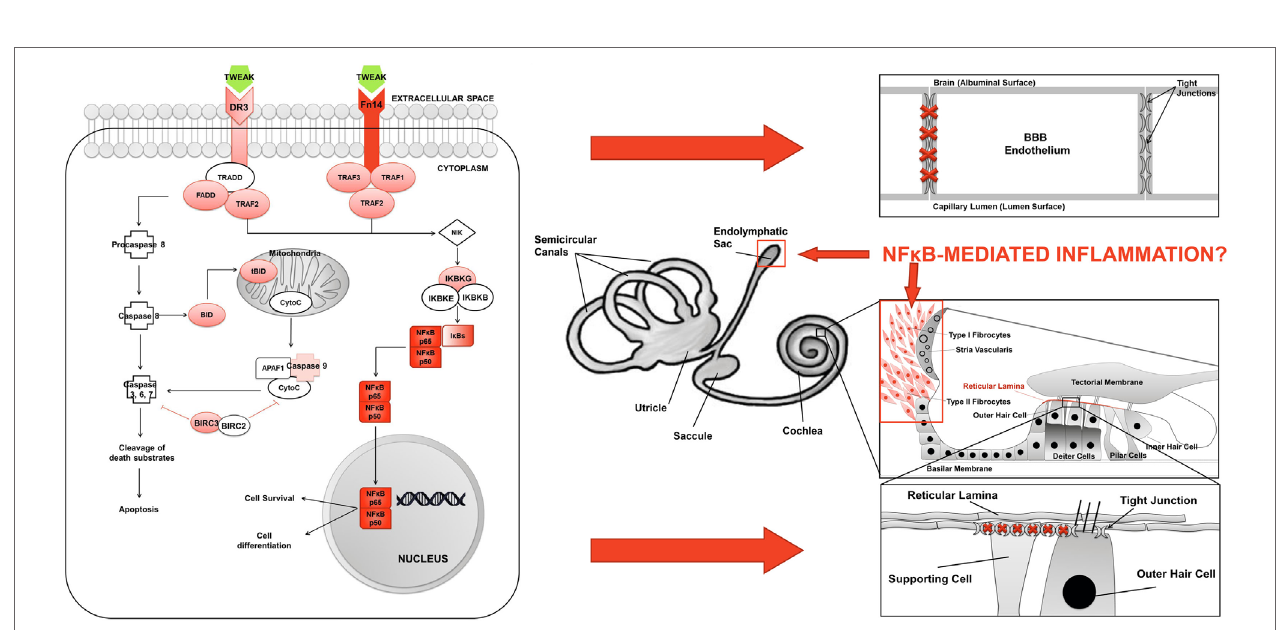
FigUre 5 | Fn14 and NF- κ B expression in homozygous lymphoblastoid cell lines (LCLs). Confocal microscopy images showing representative clusters of LCLs with Fn14 and NF- κ B immunolabeling after treatment with 250 ng/mL of TWEAK. CC, risk genotype; TT, protective genotype.